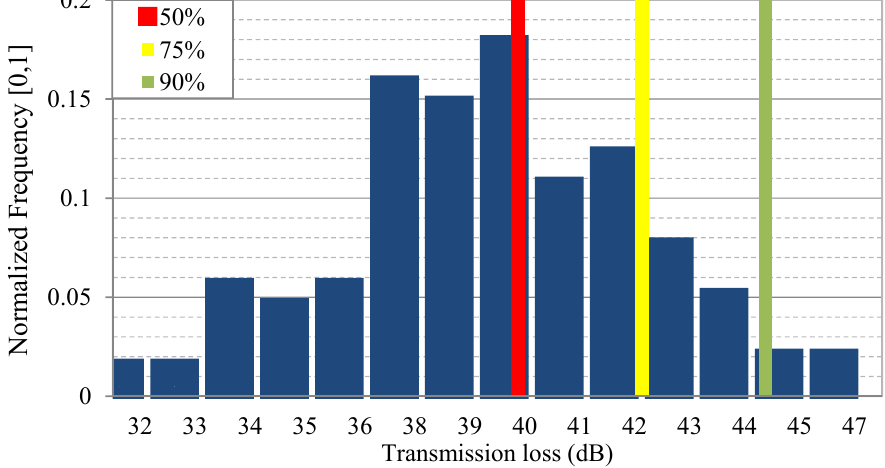
Figure 11. Transmission loss normalized histogram of an ensemble of channel